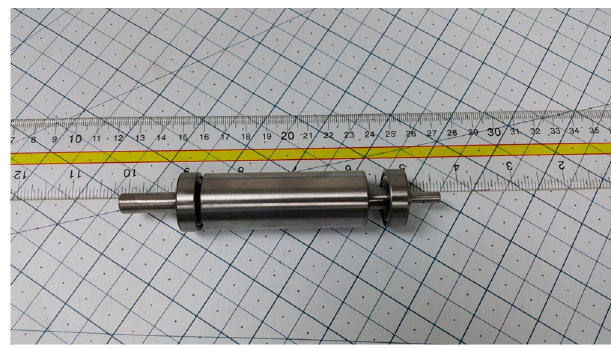
Figure 7. Experimental apparatus bearing loss calibration rotor hardware.